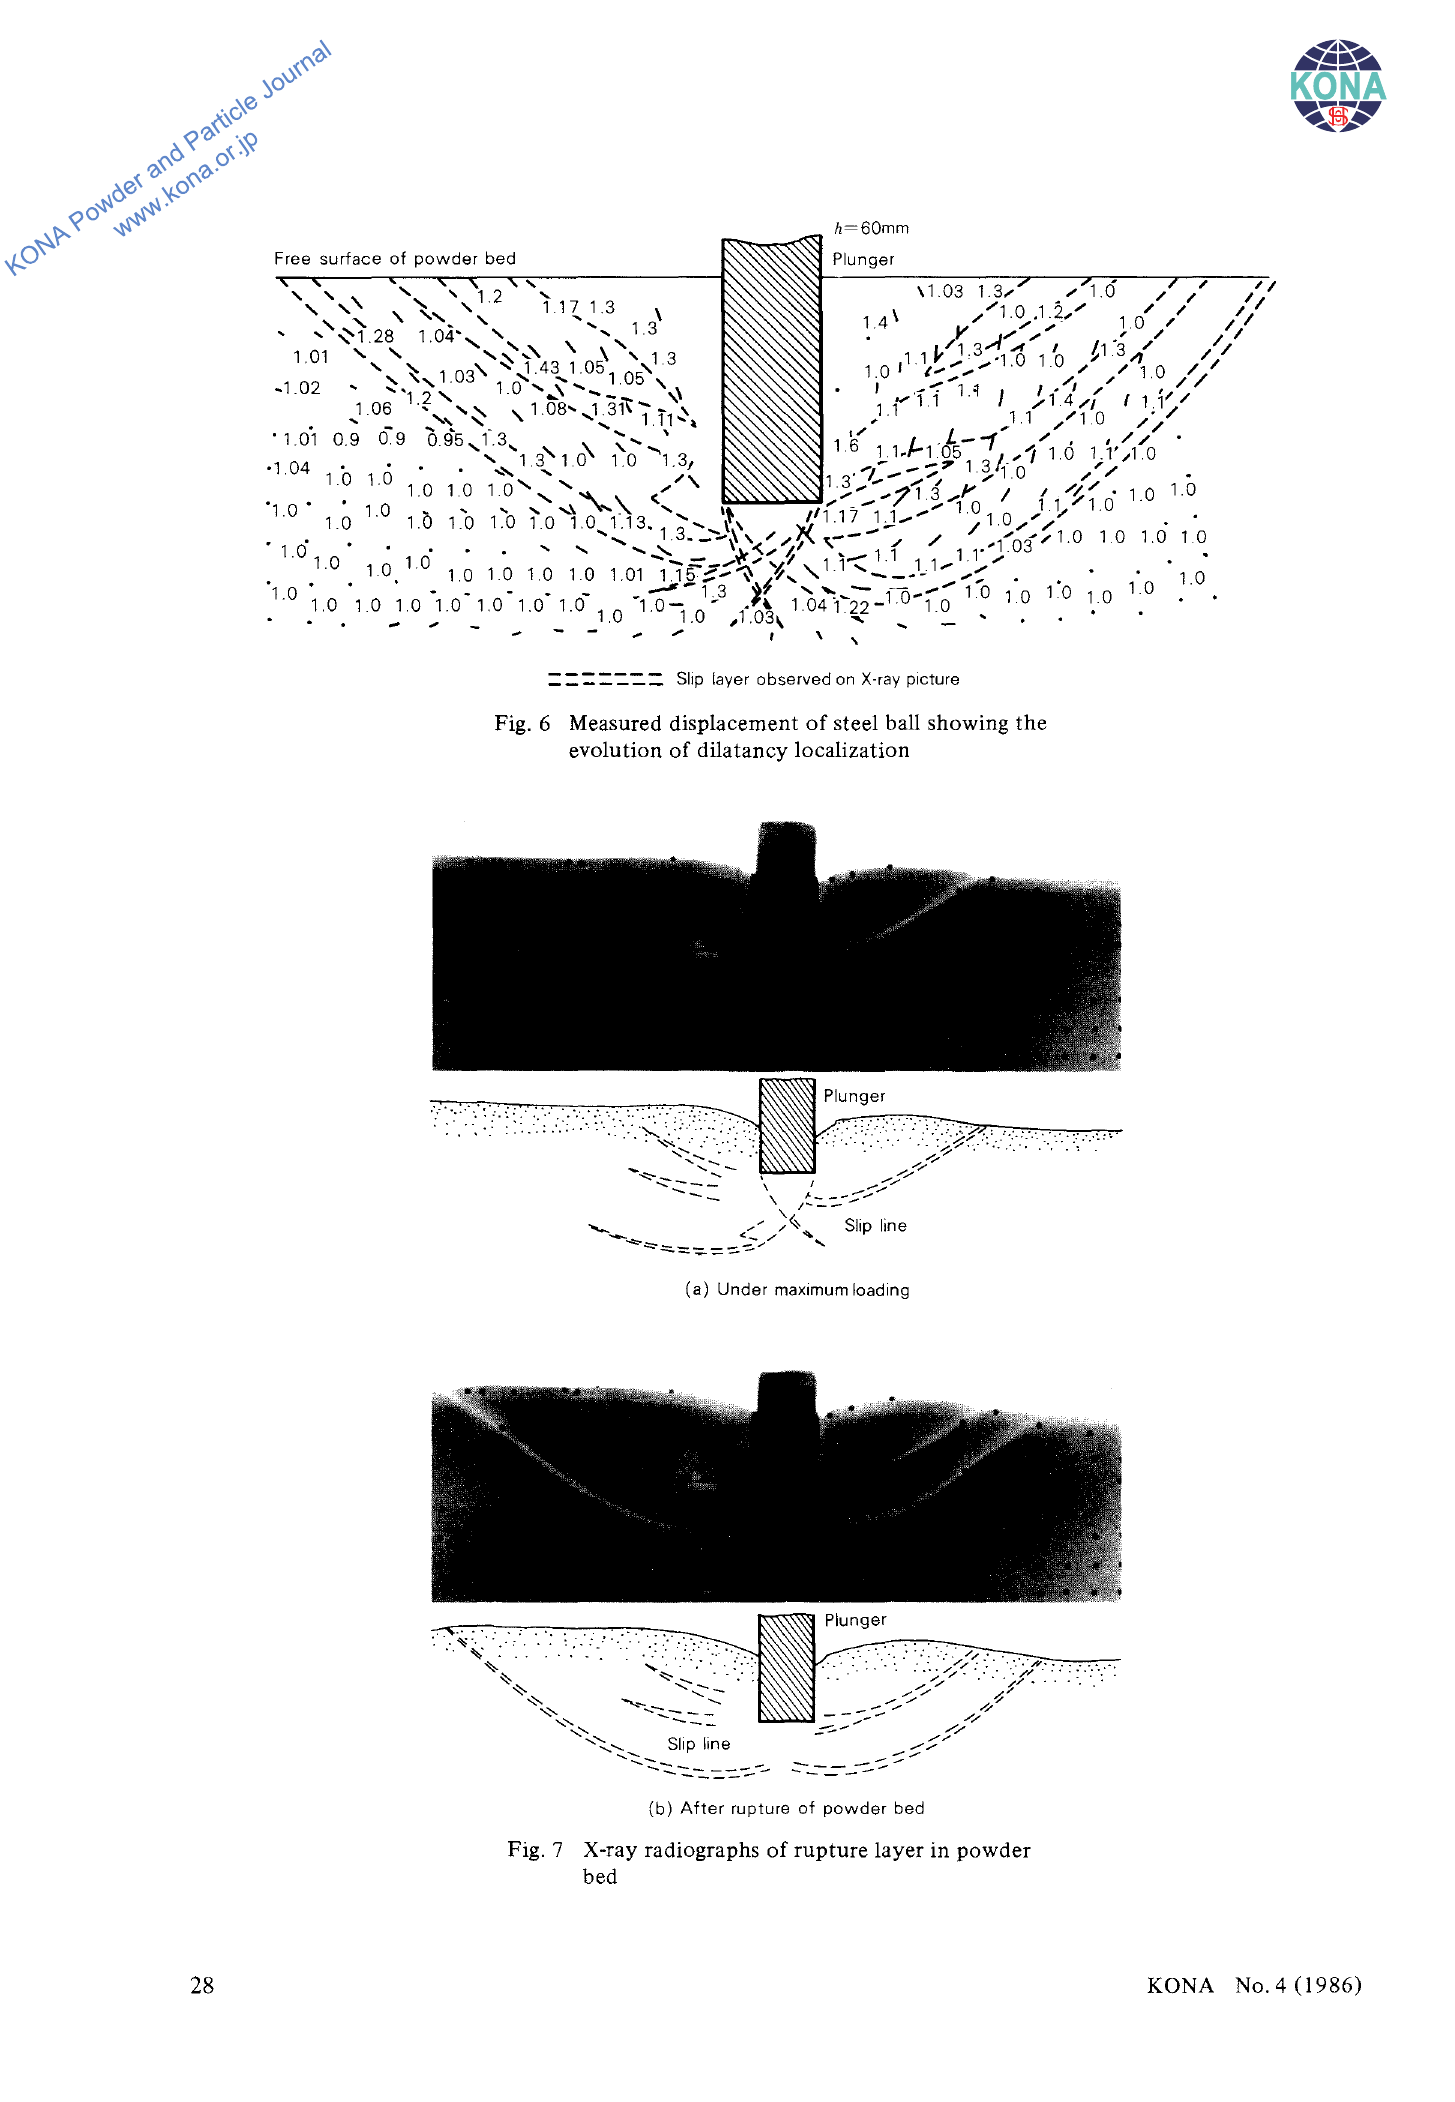
Fig. 7 X-ray radiographs of rupture layer in